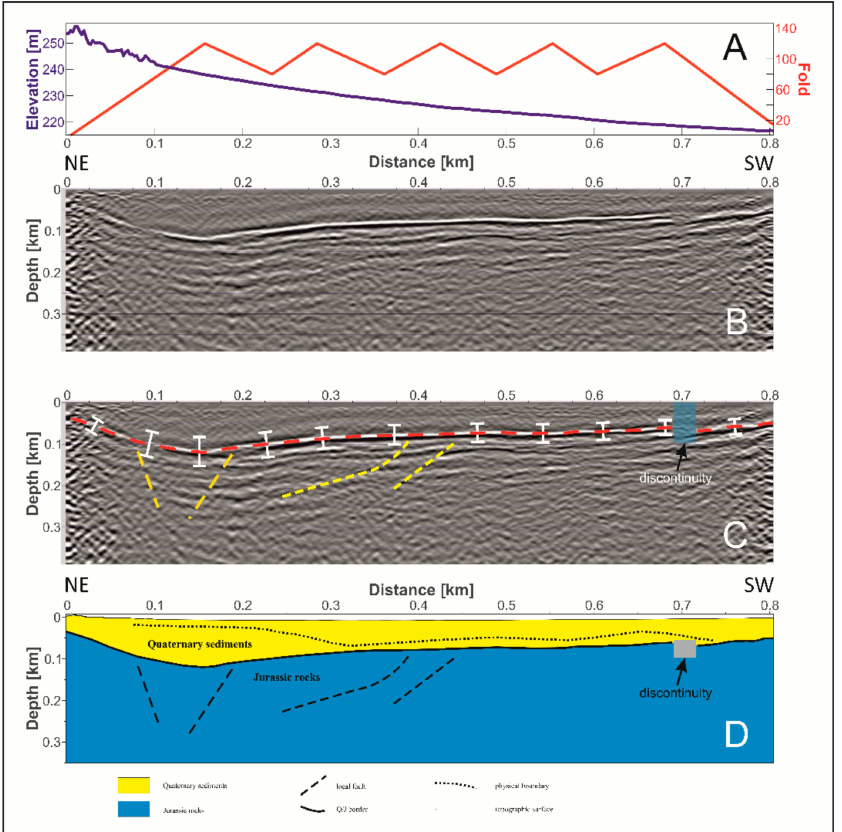
Figure 6. The result of the reflection seismic imaging: ( A ) Elevation and fold. Thanks to acquisition geometry in the form of six deployments, a good seismic fold along the whole profile was achieved; ( B ) seismic stack in the depth domain; ( C ) interpretation of the seismic image. Considered as the Mesozoic bedrock, the main reflecting horizon (red dashed line) is clearly visible in the seismic section. Its depression in the NE is probably related to the syncline structure and / or erosion. In the middle of the seismic stack (yellow dashed line), there are four detachments, probably connected to a local fault. White bars show the estimated uncertainty of determination of the interpreted horizon. The blue area corresponds to the discontinuity of the Mesozoic bedrock; ( D ) geological interpretation of all